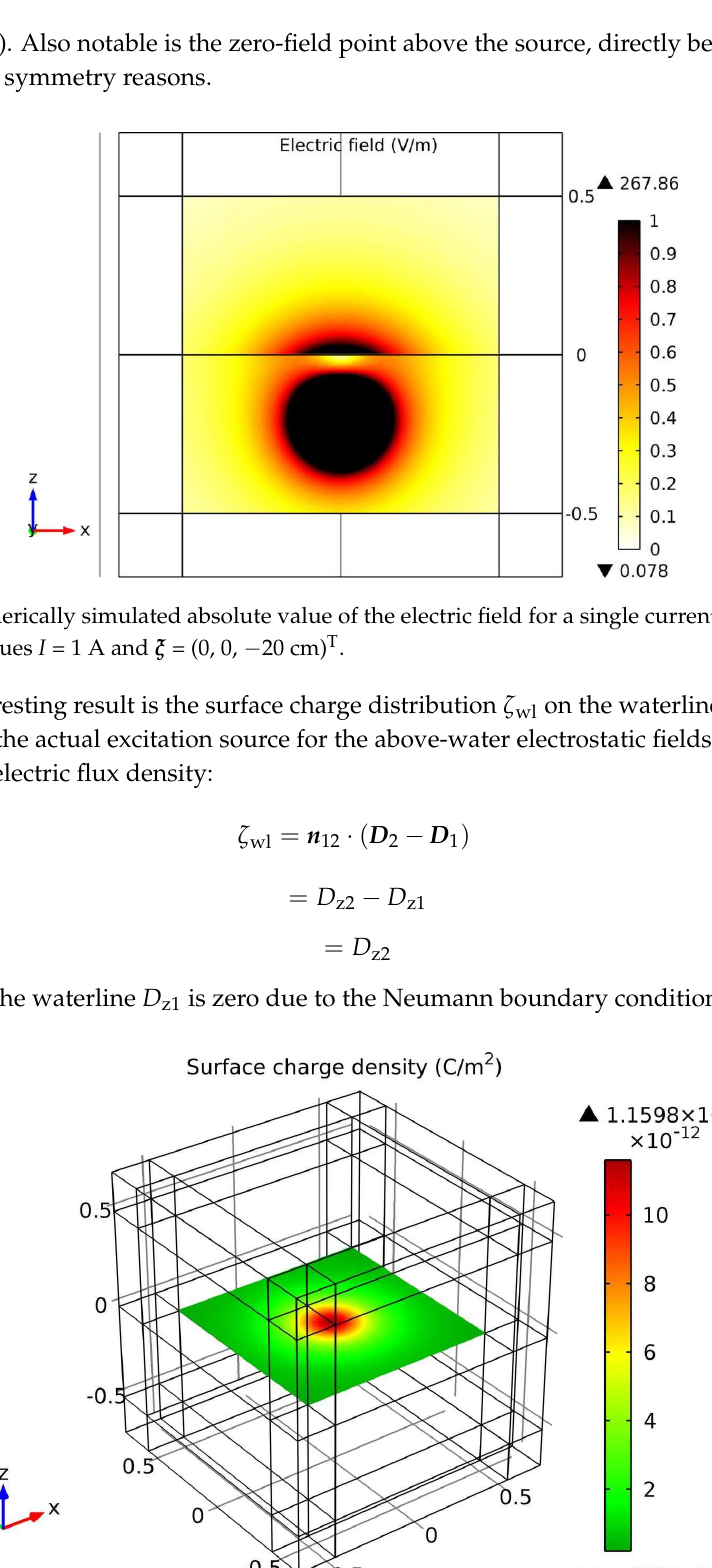
Figure 7. Numerically simulated absolute value of the surface charge density ζ wl at the water–air interface, for a single current source I with considered values I = 1 A and ξ = (0, 0, −20 cm) T .